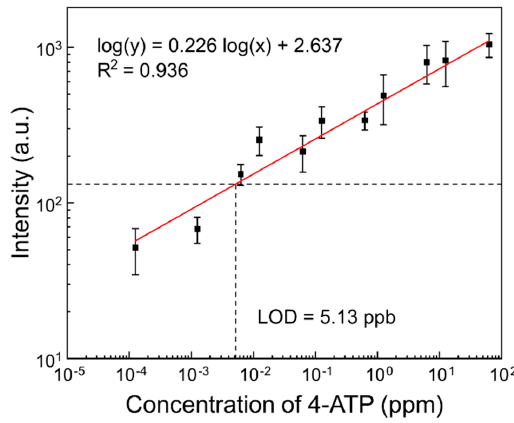
Figure 7. SERS intensity at 1070 cm − 1 obtained from a series of different concentrations of 4-ATP dropped onto prepared SERS substrates (analyte concentration ranging from 0.00125 ppm to 12.5 ppm).